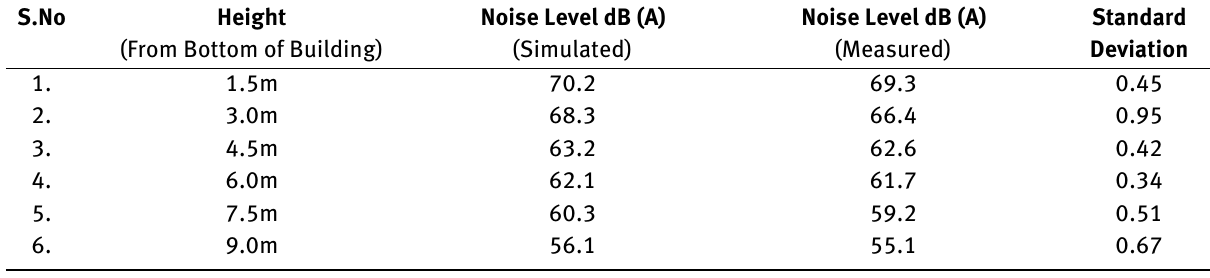
Table 1: Validation of 3D noise map